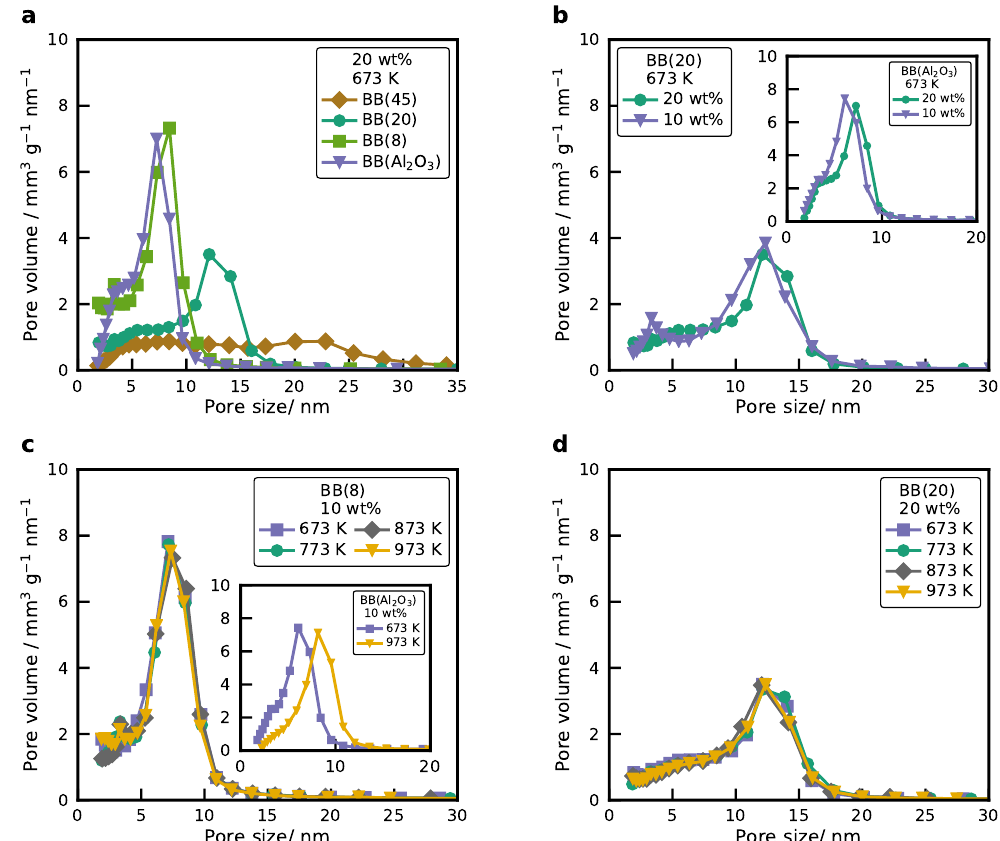
Figure 3. ( a ) Pore size distribution of BB(8), BB(20), BB(45), and BB(Al 2 O 3 ) with 20wt% of Ni, calcined at 673K. ( b ) Pore size distribution of BB(20) and BB(Al 2 O 3 ) (inset) with two different nickel loadings (10 and 20wt%), calcined at 673K. ( c ) Pore size distribution of BB(8) and BB(Al 2 O 3 ) (inset) with 10wt% of Ni calcined at different temperatures. ( d ) Pore size distribution of BB(20) with 20wt% of Ni calcined at different